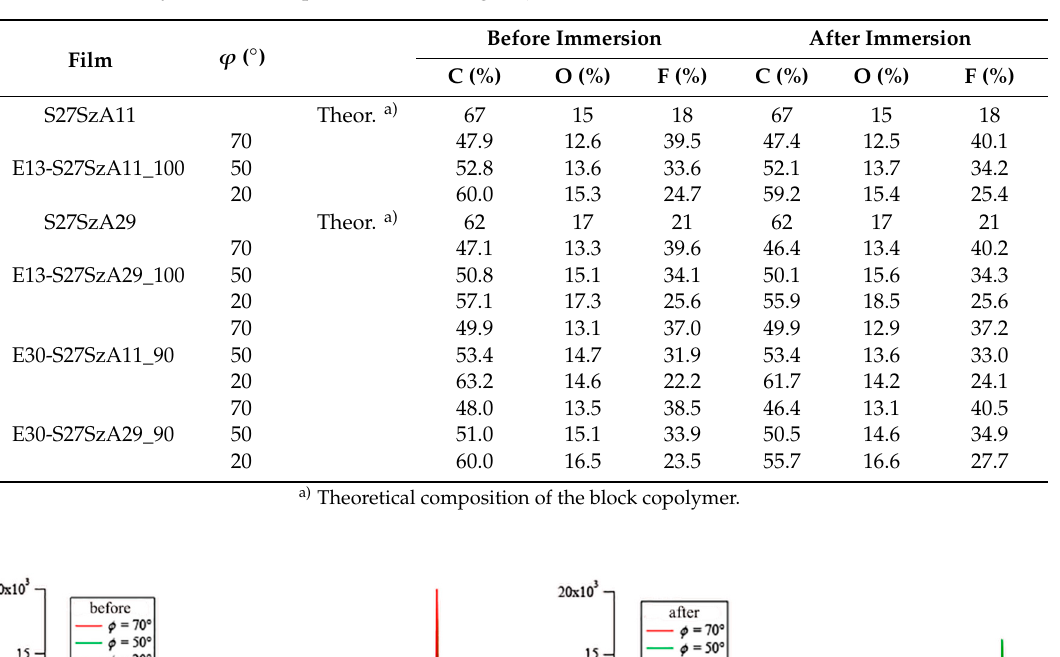
Table 6. Experimental XPS atomic composition of the two-layer films before and after immersion in water for 7 days at di ff erent photoemission angles ϕ .